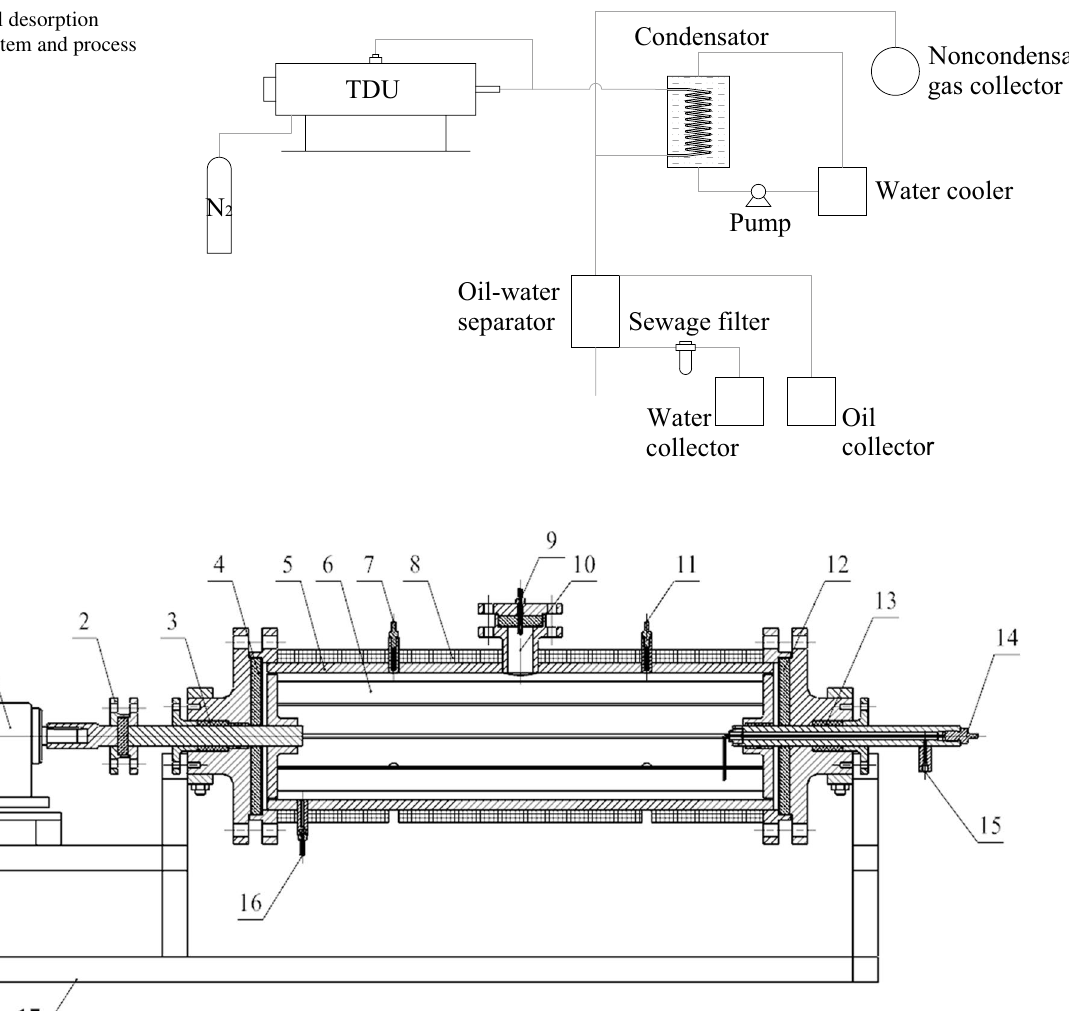
exhausting connector; 10 feeding/sampling port; 11 thermocouple; 12 heat shield; 13 packing seal; 14 thermocouple; 15 exhausting connec- tor; 16 nitrogen connector; 17 support